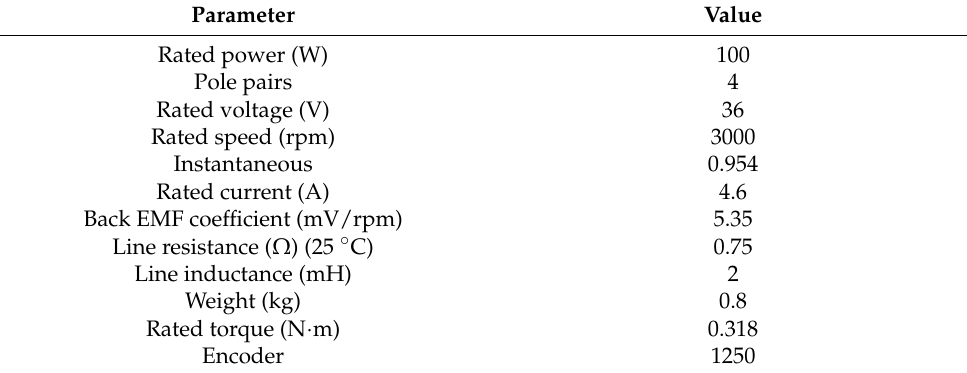
Table 2. I-ADRC parameter list.